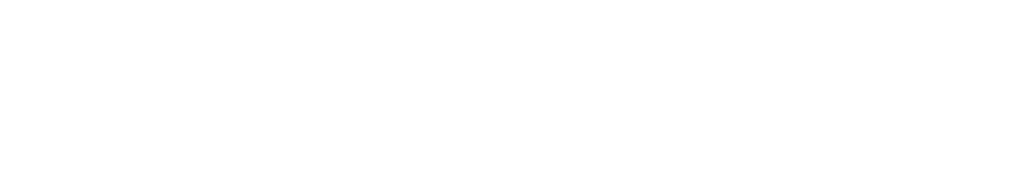
Logopediese Vereniging, Vol. 17, Nr. : Des.